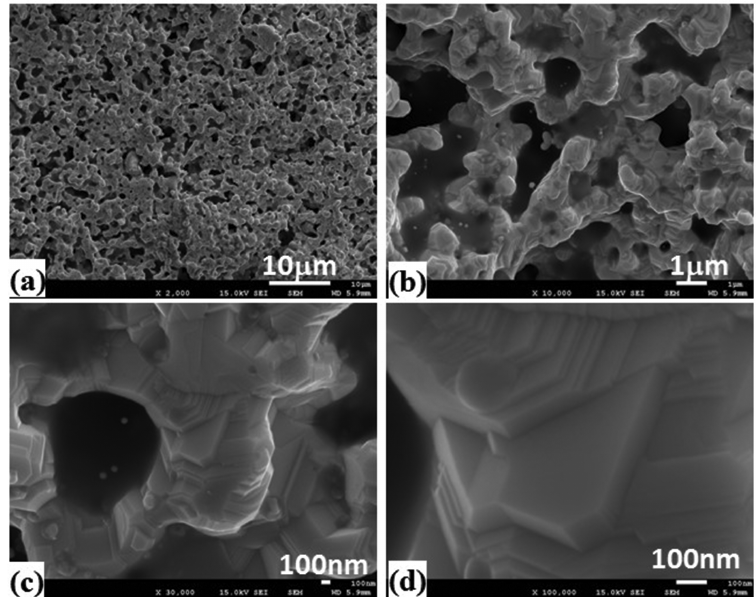
Figure 7: Pt surface before experiment after heat treatment at 1,000°C for 2 h in